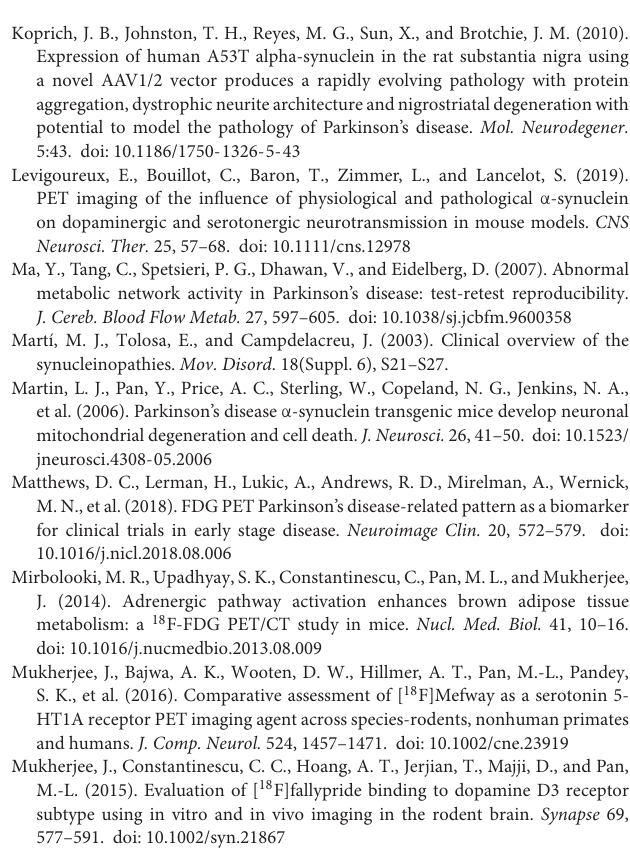
Supplementary Figure 1 | Comparison of difference between non-carrier and A53T PD mice in SUV units in males and females of [ 18 F]FDG uptake in different brain regions. Supplementary Figure 2 | Immunostained cortex brain regions in non-carrier mice (A) and A53T PD mice (B) using Millipore anti- α -synuclein polyclonal antibody (#AB5038). Greater accumulation of α -synuclein aggregates were observed in the A53T PD mice. Supplementary Figure 3 | Hypometabolism measured by [ 18 F]FDG uptake in the lumbosacral regions (arrows) of the A53T PD mice (B) compared to the non-carrier mice (A) . Supplementary Table 1 | Details of non-carrier mice and A53T PD mice used in the study. Supplementary Table 2 | CT analysis of non-carrier mice and A53T PD